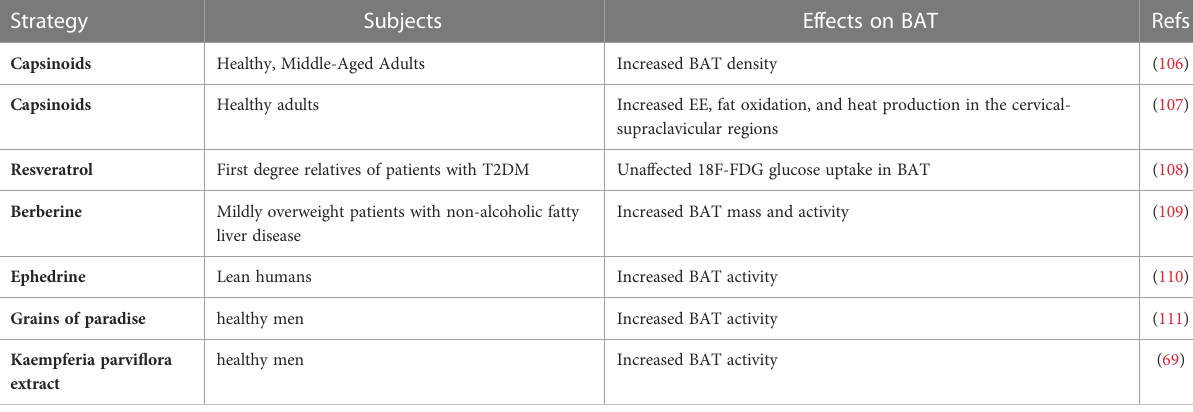
TABLE 2 Clinical trials of effects of dietary compounds on